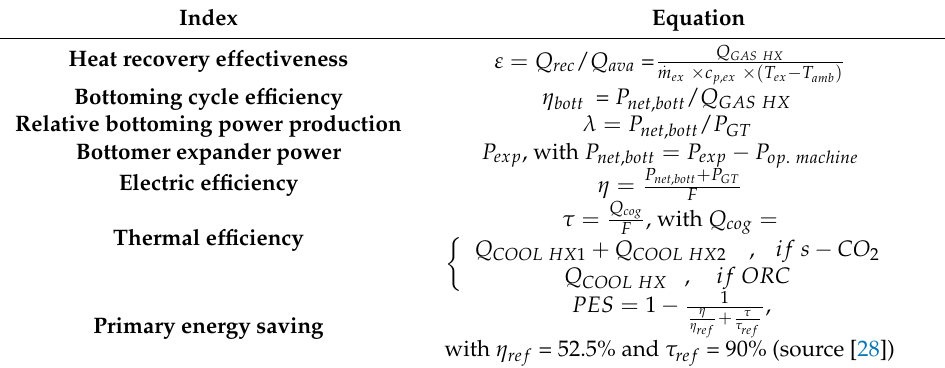
Table 3. Performance indexes for design performance